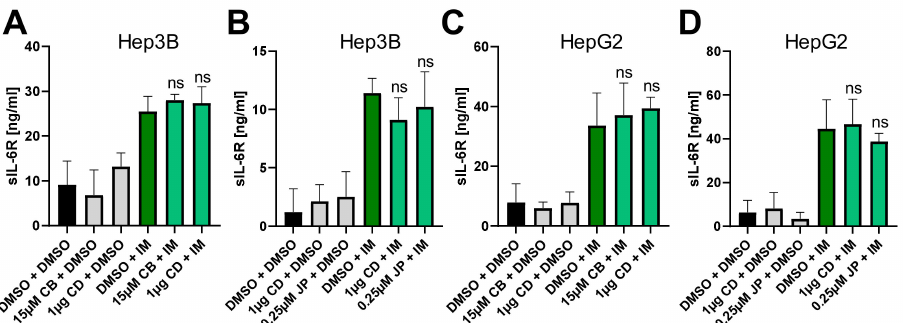
Figure 4. Perturbation of the actin cytoskeleton does not influence IL-6R proteolysis by ADAM10. ( A , B ) ELISA quantification of sIL-6R in culture supernatant after pretreatment of Hep3B cells with ( A ) cytochalasin B (15 µ M) and D (1 µ g) or ( B ) cytochalasin D (1 µ g) and jasplakinolide (0.25 µ M) for 120 min. Proteolysis by ADAM10 was activated via ionomycin (1 µ M) for 60 min. Data are shown as means ± SD of three independent experiments. ( C , D ) The experiments were performed as described for panels A and B, but HepG2 cells were used. Data are shown as means ± SD of three independent experiments. Statistical significance was determined using one-way ANOVA with Sidaks’s multiple comparisons test (cells pre-treated with actin-modulating compounds and stimulated with ionomycin were compared to ionomycin-stimulated cells only). ns = no significant difference; CB: cytochalasin B; CD: cytochalasin D; JP: jasplakinolide; IM: